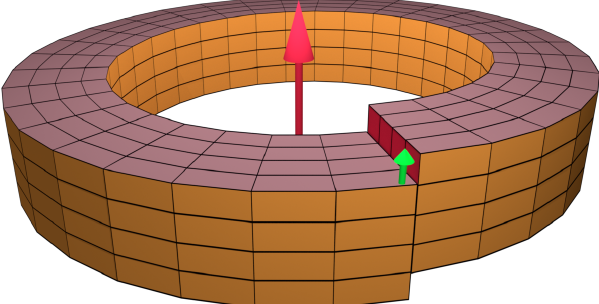
Figure 5: Illustration of a screw dislocation. When a Burgers loop is taken around the dislocation line (large red arrow), an extra step is needed vertically to close the loop. The resulting Burgers vector (small green arrow) is therefore parallel to the dislocation